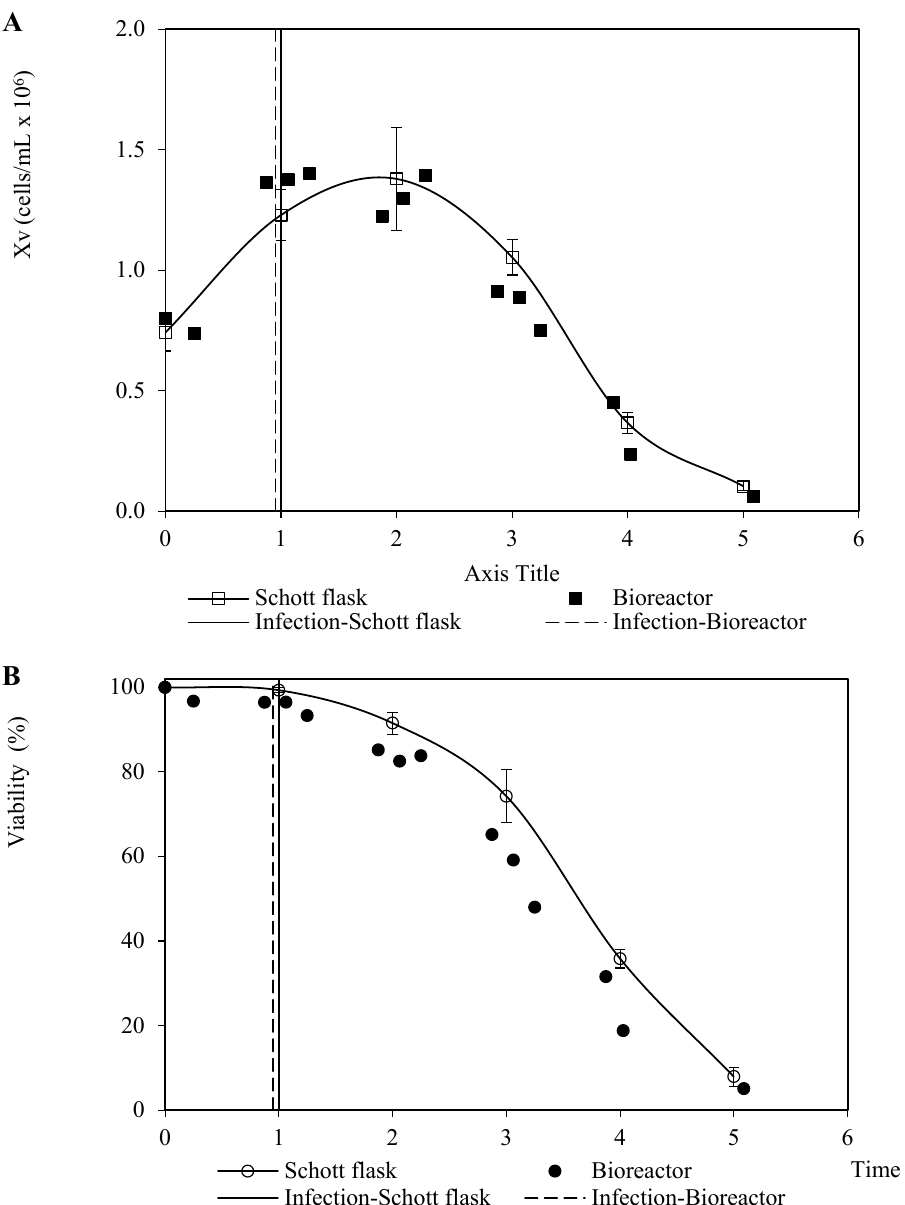
Figure 2. Patterns of viable cell density and viability corresponding to Sf9 cells infected with recombinant baculovirus carrying the rabies G glycoprotein at 0.1 pfu/cell MOI in Schott flask and bioreactor. ( A ) Viable cell density pattern. ( B ) Viability pattern. The points and error bars from Schott flask assays represent the average and the standard deviation of three repetitions, respectively.